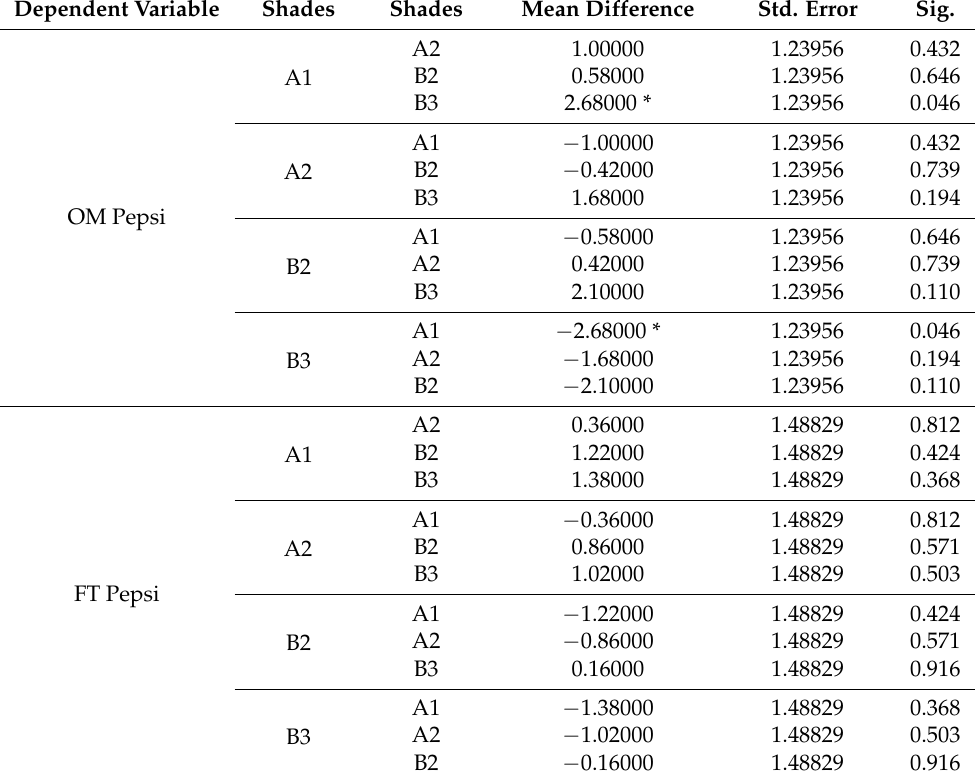
Table 3. Post-Hoc